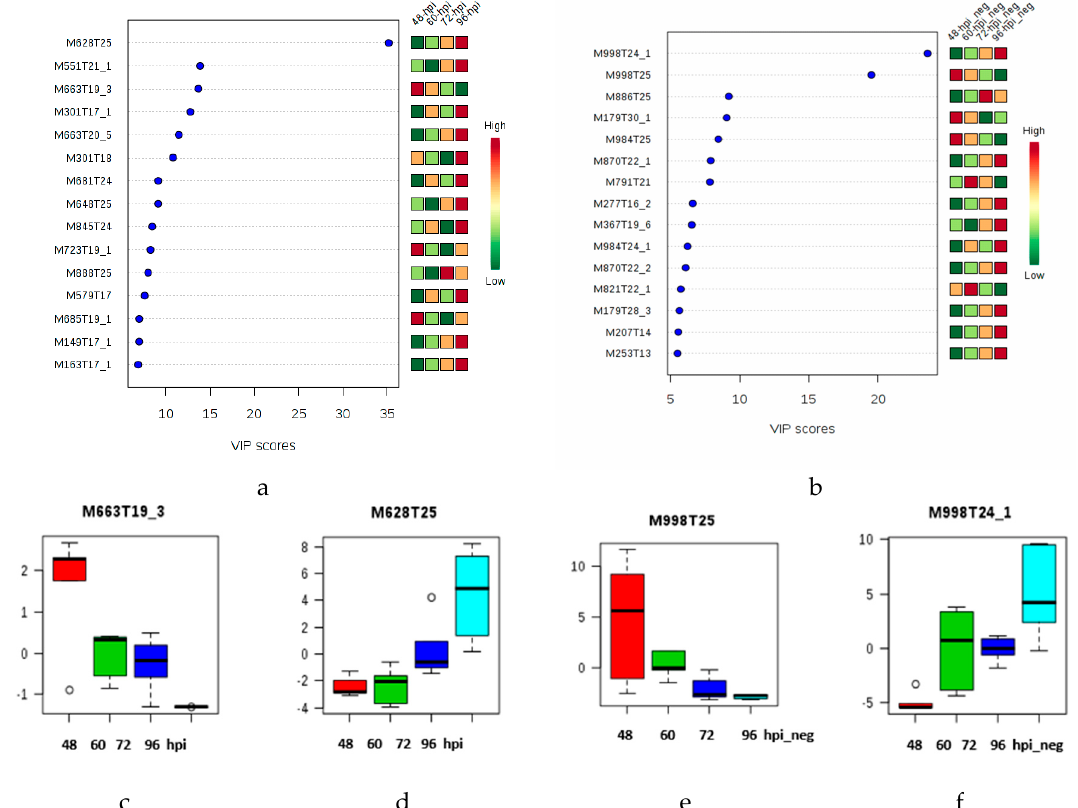
Figure 3. VIP score-plots derived from the PLS-DA analysis displaying discriminant features at the late infection stage (cluster II: 48, 60, 72 and 96 hpi): ( a ) LC-ESI (+)-MS and ( b ) LC-ESI ( − )-MS. Coding of M and T after the number respectively indicates the nominal mass and retention time of each feature. ( c – f ). Box plots from s-plot of the molecular features M663T19 ( m / z 663.4508), M628T25 ( m / z 628.3657), M998T24 ( m / z 997.5185) and M998T25 ( m / z 997.5184), respectively. In the box plot, Y axis represents intensity of the metabolites as quartile for each sample group related to all data set. The range of the vertical scale is from the minimum to the maximum value of the selected group, or, to the highest or lowest of the displayed reference points, median, and 95% confidence interval of the mean. Coding 48-hpi means positive ionization mode analysis of the samples collected at forty-eight hours post infection. Coding 48-hpi_neg means negative ionization mode analysis of the samples collected at forty-eight hours post infection. Coding C and C_neg means the analysis of the controls in positive and negative ionization modes, respectively.